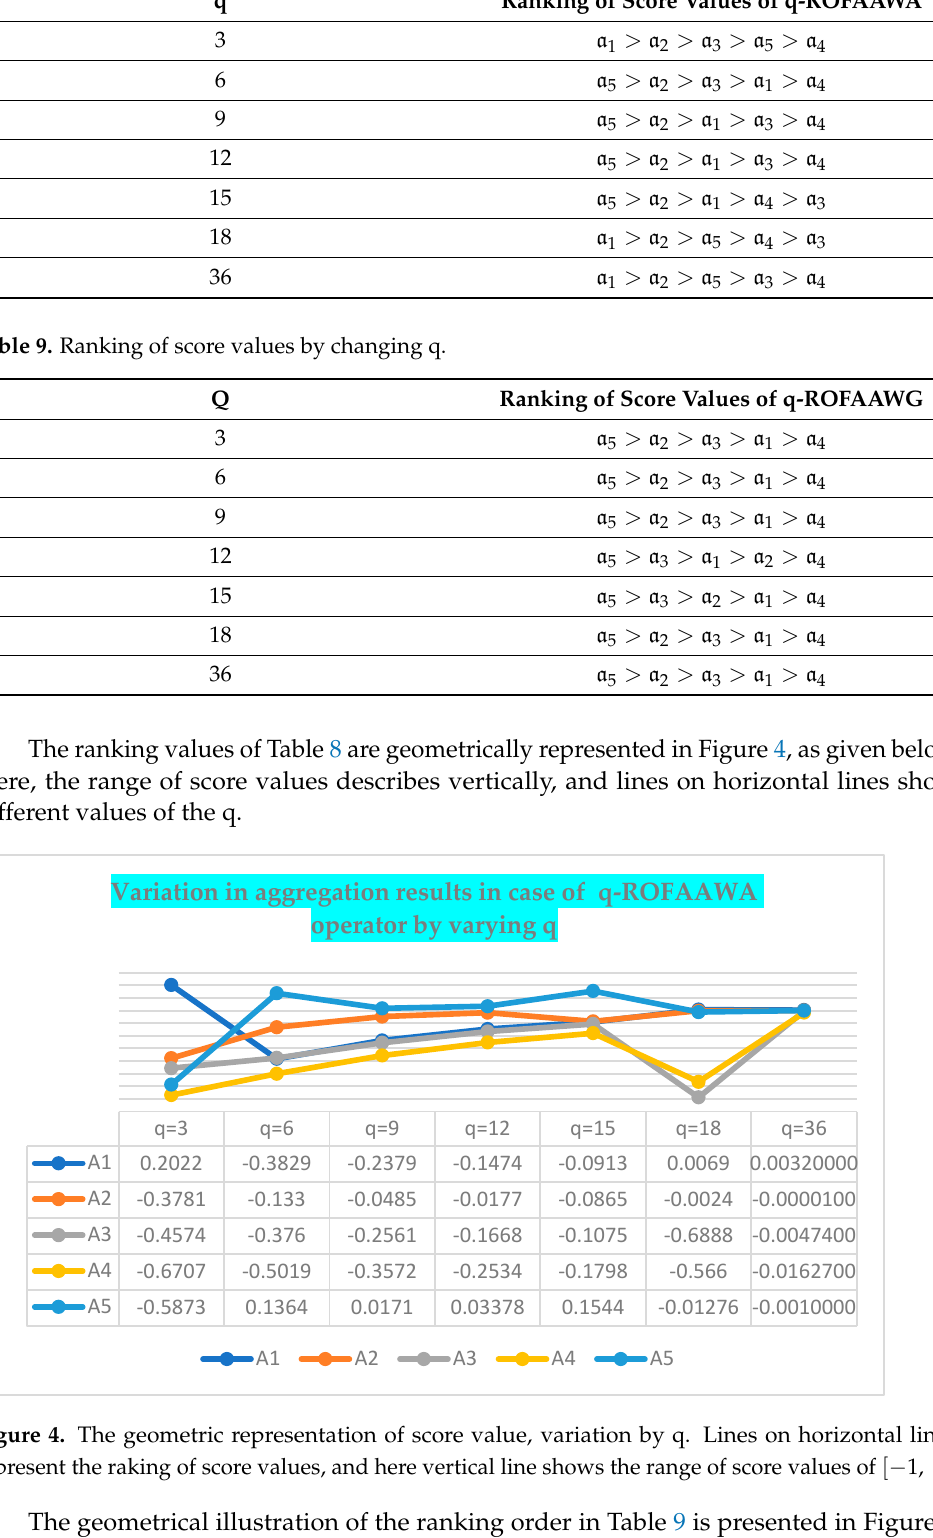
Table 8. Ranking of score values by changing q .